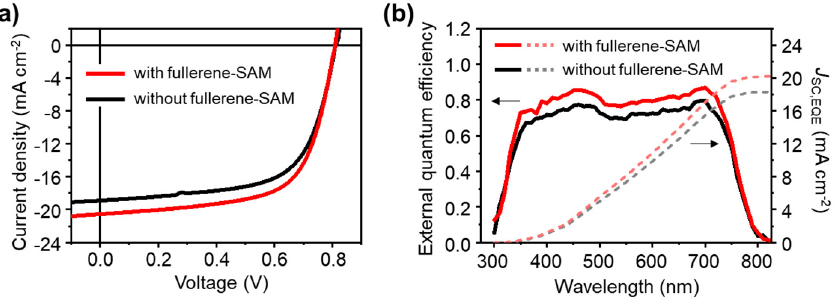
Figure 3. Photovoltaic characteristics of devices with and without fullerene-SAM treatment. ( a ) J – V characteristics. ( b ) EQE spectra and corresponding J SC,EQE , calculated by integrating EQE data. Table 2. Photovoltaic parameters of devices with and without fullerene-SAM